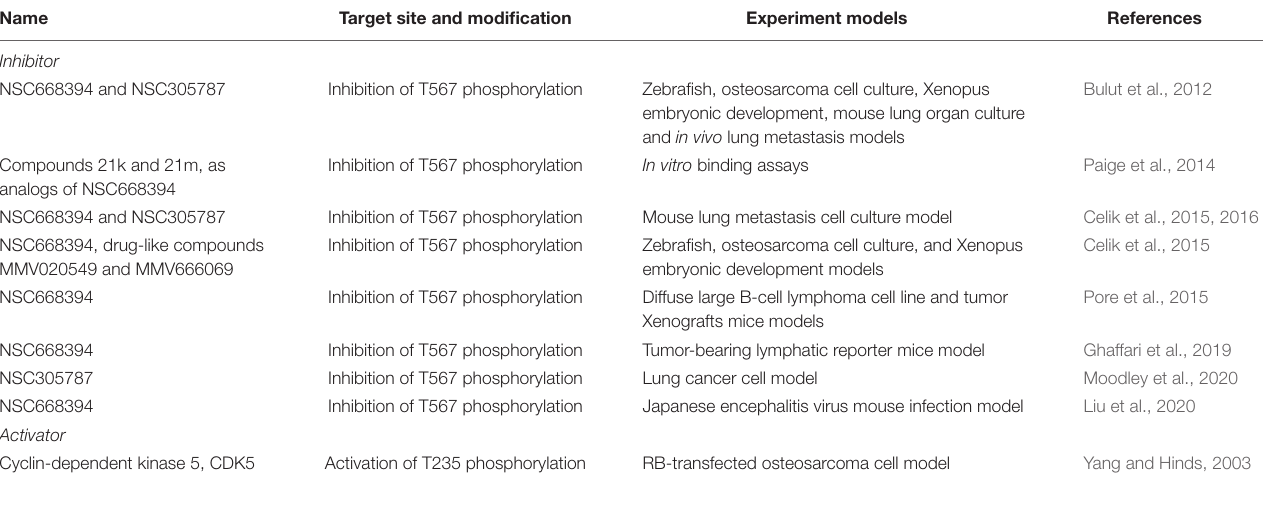
TABLE 3 | Pharmacological inhibitors and activators targeting